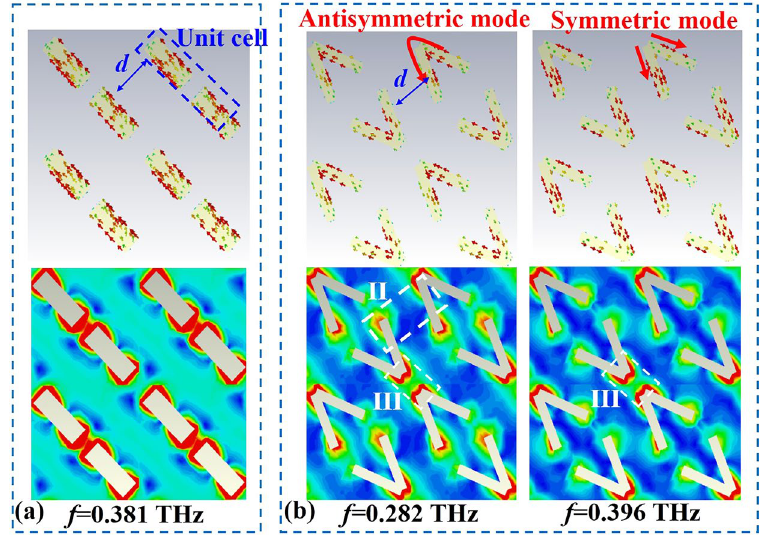
Figure 5. Surface current (upper parts) and electric field (lower parts) distributions on the middle metasurface; the red arrows denote the direction of surface current. ( a ) α = 0° and ( b ) α = 45°.